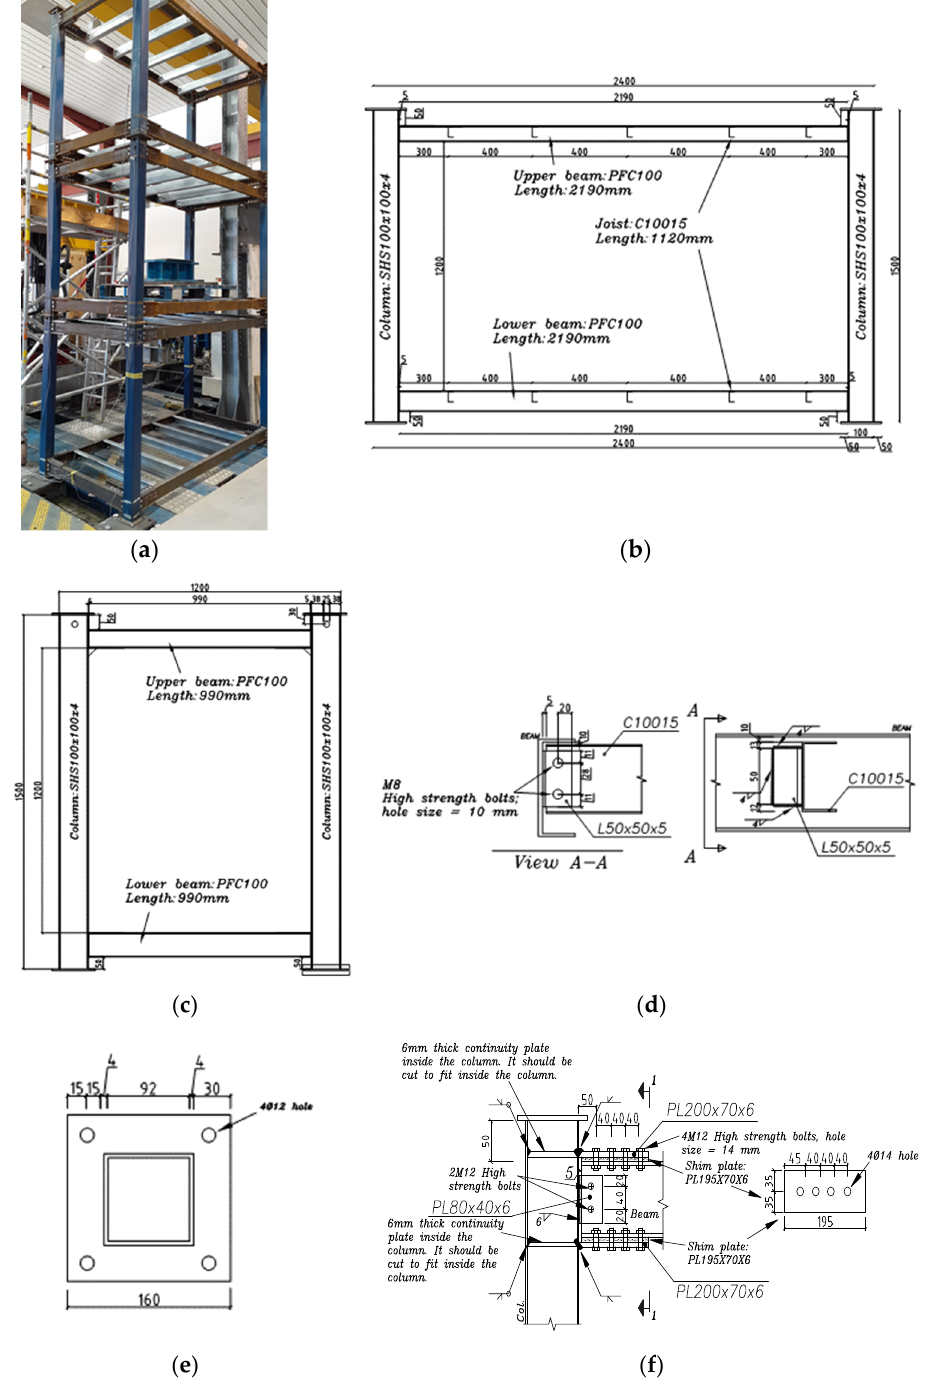
Figure 2. ( a ) Three-dimensional view of the test specimen; ( b ) details of a modular unit in the longitudinal direction; ( c ) details of a modular unit in the transverse direction; ( d ) details of joist connections; ( e ) details of inter-connections; ( f ) details of intra-connections. Beams at floor and ceiling levels are made of PFC100 in both longitudinal and trans- verse directions. Columns are made of SHS100 × 100 × 4 mm, which is a typical section for they are connected to longitudinal beams at both ceiling and floor levels. The distance